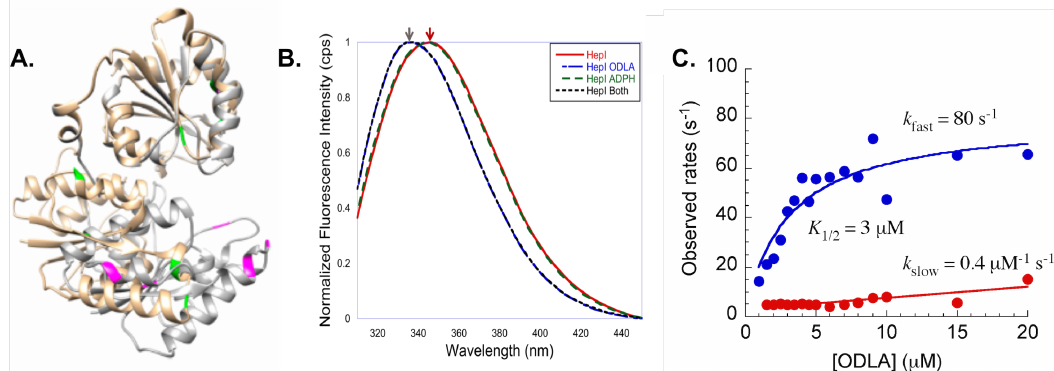
Figure 10. ( A ) HepI open structure (tan) and trypophan residues colored in green is superimposed with a structural model of closed HepI (gray) with tryptophans colored magenta; ( B ) Steady state intrinsic tryptophan emission spectra of HepI with and without substrates bound, blue shift is observed upon ODLA binding; ( C ) Pre-steady state kinetics of WT HepI titrated with ODLA (fast phase, blue; slow phase,